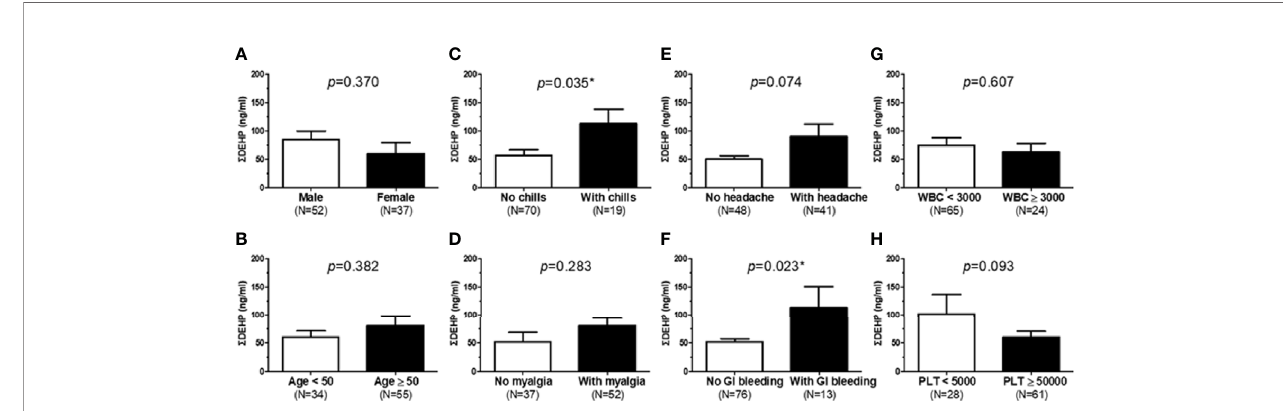
FIGURE 1 | Analysis of correlations between DEHP exposure and typical symptoms in 89 dengue patients. (A, B) DEHP levels between sex and age were analyzed. (C) DEHP levels between dengue patients with or without chills. (D) DEHP levels between dengue patients with or without myalgia. (E) DEHP levels between dengue patients with or without headache. (F) DEHP levels between dengue patients with or without gastrointestinal (GI) tract bleeding. (G) DEHP levels between white blood cell (WBC) counts (cells/ m l) in dengue patients. (H) DEHP levels between platelet (PLT) counts (cells/ m l) in dengue patients. Patients with chills and GI bleeding showed signi fi cantly higher levels of DEHP. *P < 0.05 by Student ’ s t-test (means ±